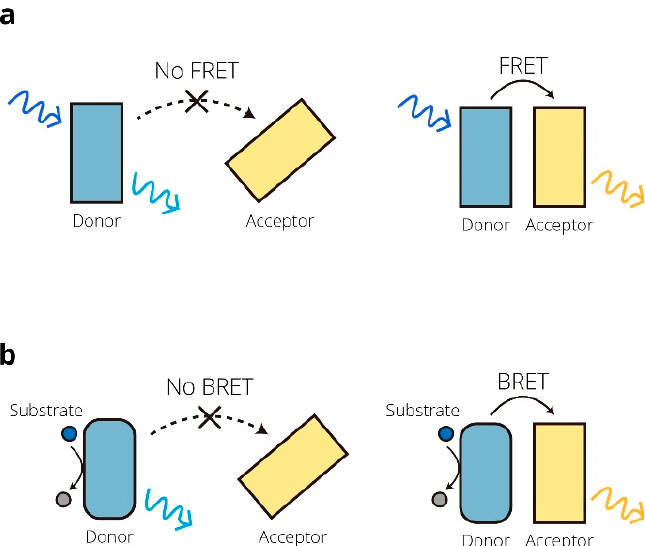
Figure 1. Principles of FRET and BRET. ( a ) Schematic representation of the FRET process, where the energy transfers from the donor to the acceptor in proximity. ( b ) Schematic representation of the BRET process. The donor luciferase oxidizes the substrate, then produces bioluminescence to excite the acceptor.